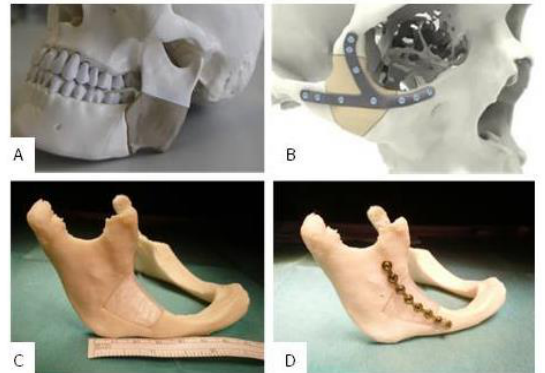
Figure 7. A: Fitted and additively manufactured polyetheretherketone (PEEK) implant by GBN Systems GmbH/Kumovis GmbH [2]; B: fitted and additively manufactured PEEK implant by